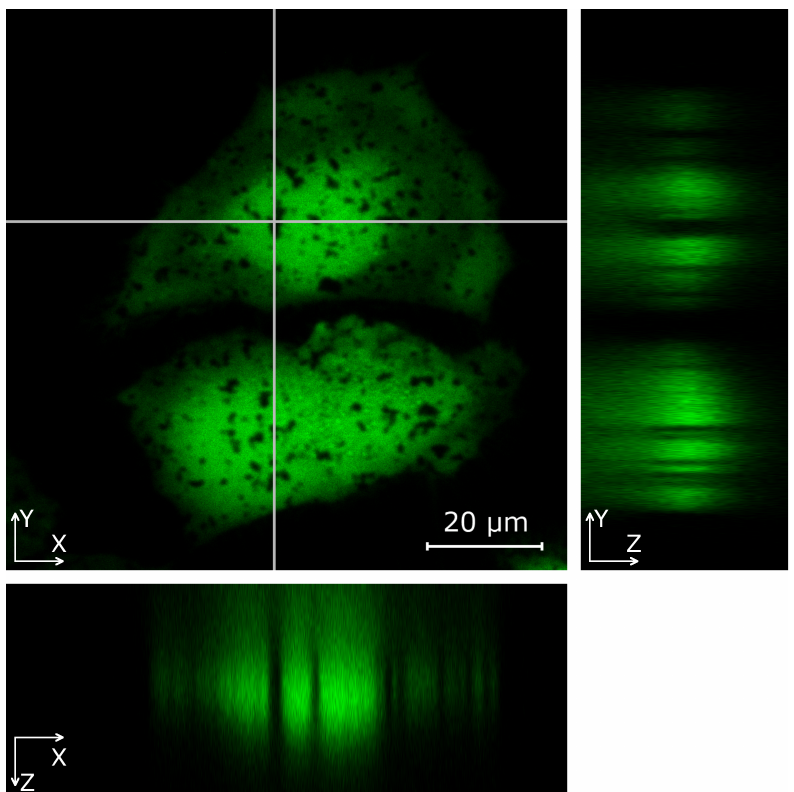
Figure 4. CLSM 3-D image of HeLa cells on the substrate with gold nanostars